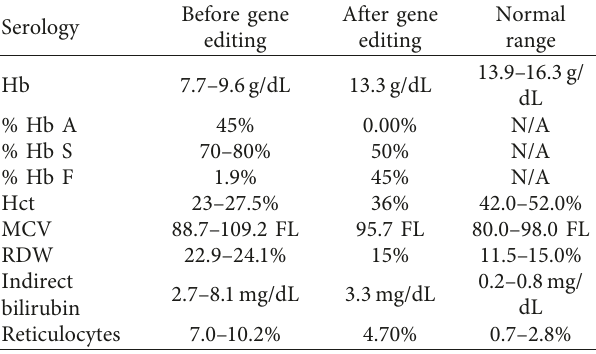
Table 1: Serologies before and after gene editing. Before gene After gene Serology editing editing